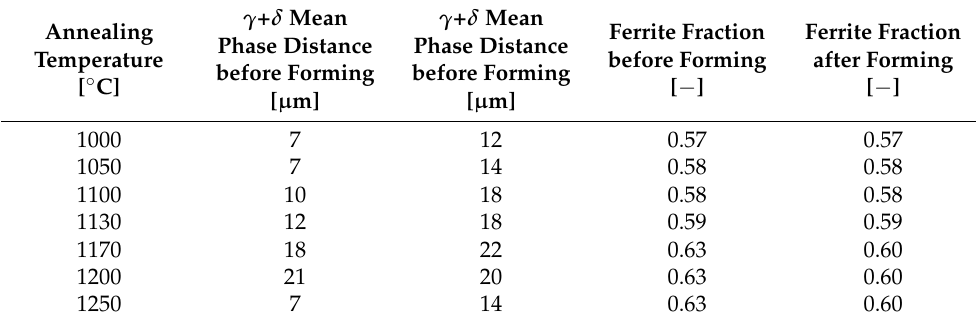
Table 4. Microstructure parameters for modelling the flow curves of duplex steels with different phase